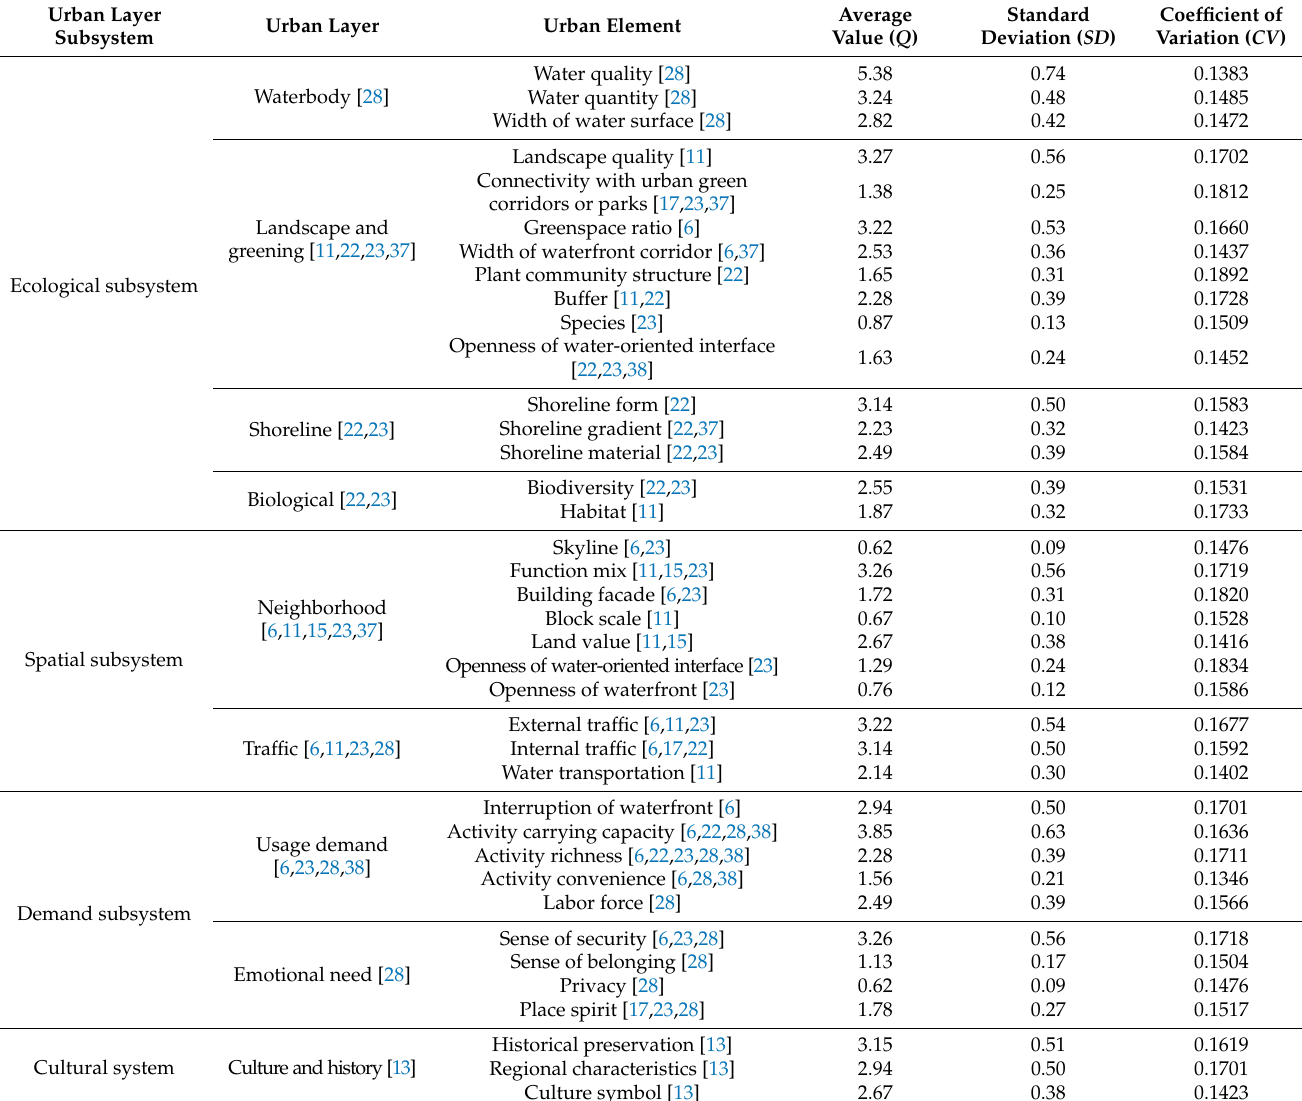
Table 1. The average value, standard deviation, and coefficient of variation of elements.